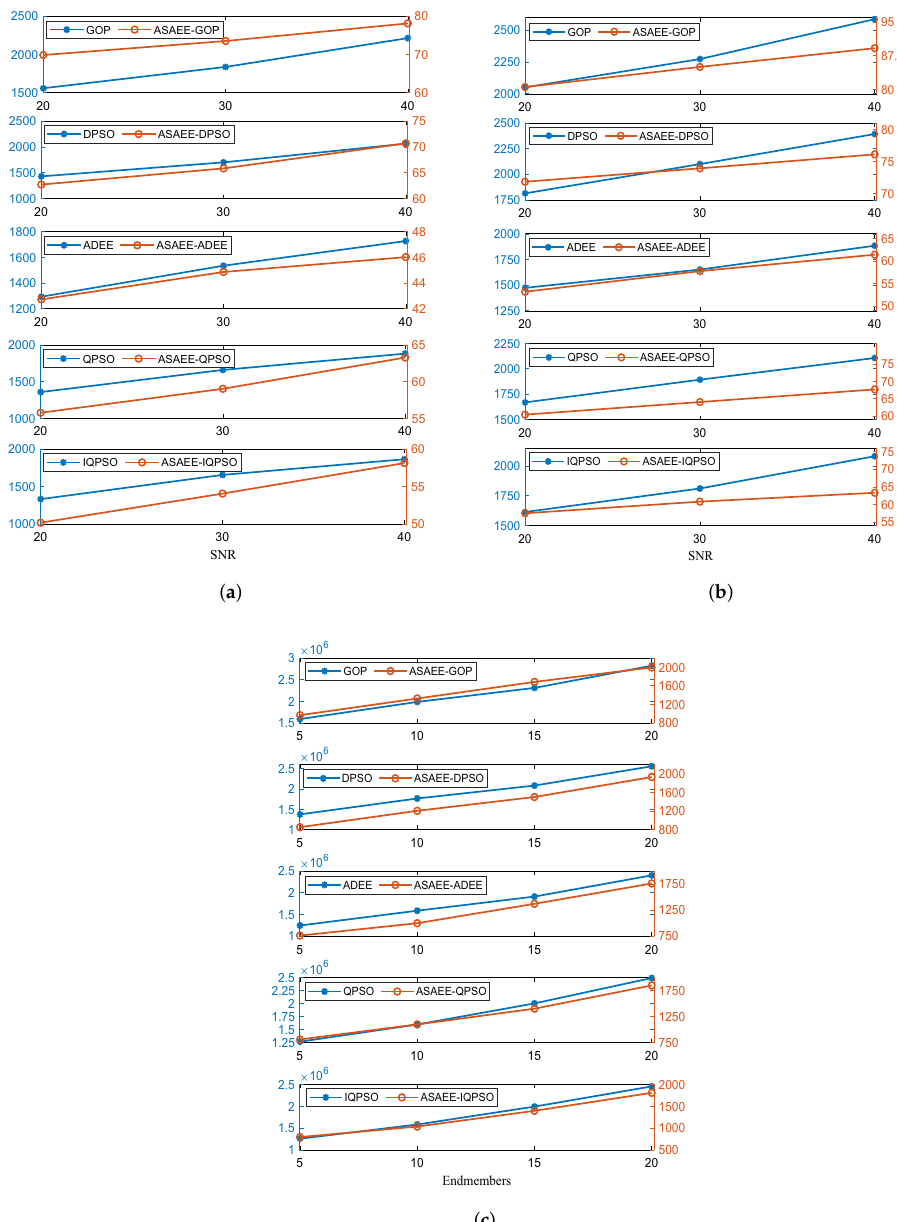
Figure 9. Time Comparison of transferring the proposed ASAEE framework to other algorithms on different data sets. ( a ) DS1. ( b ) DS2. ( c )